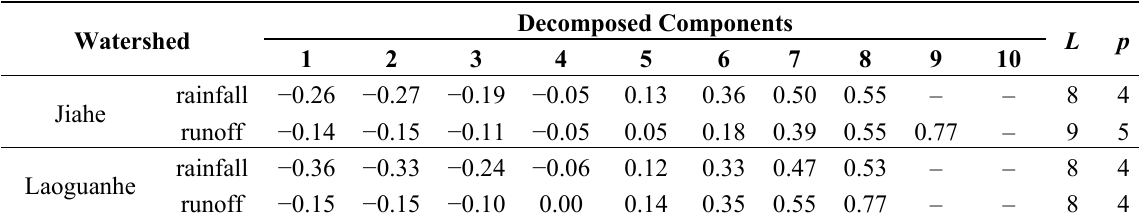
Figure 5. Singular values as a function of different window length L for runoff series. Table 2. Cross-correlation function (CCF) values between each decomposed component and original